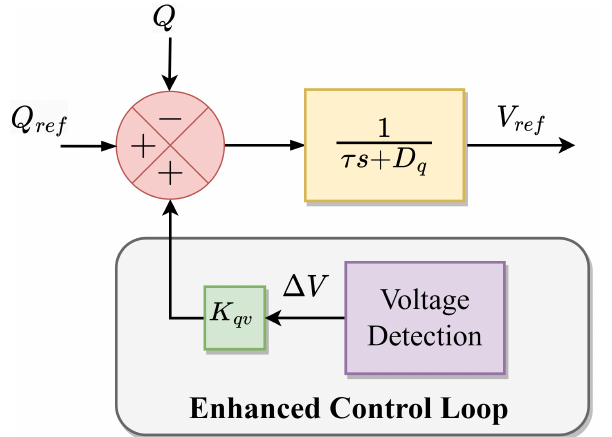
Figure 19. Increasing reactive power reference